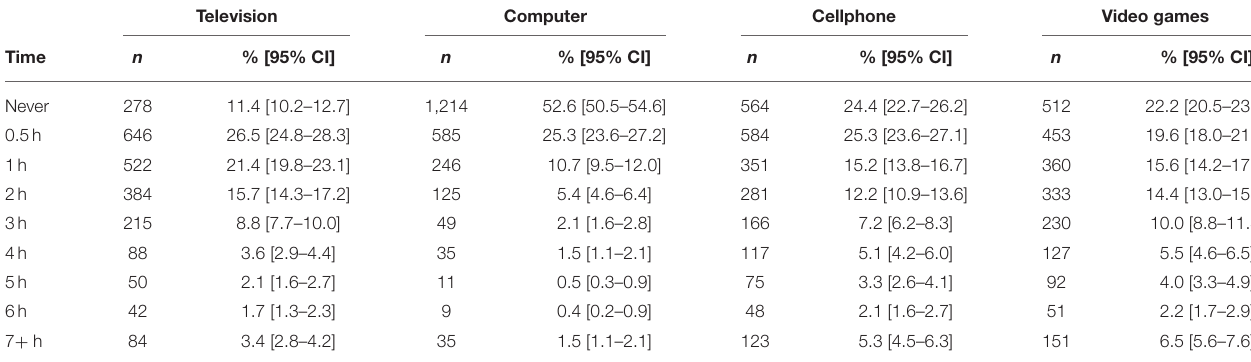
TABLE 3B | Percentage of students by time spent using technological devices every day of weekends ( n = 2,309; Missing data = 131).